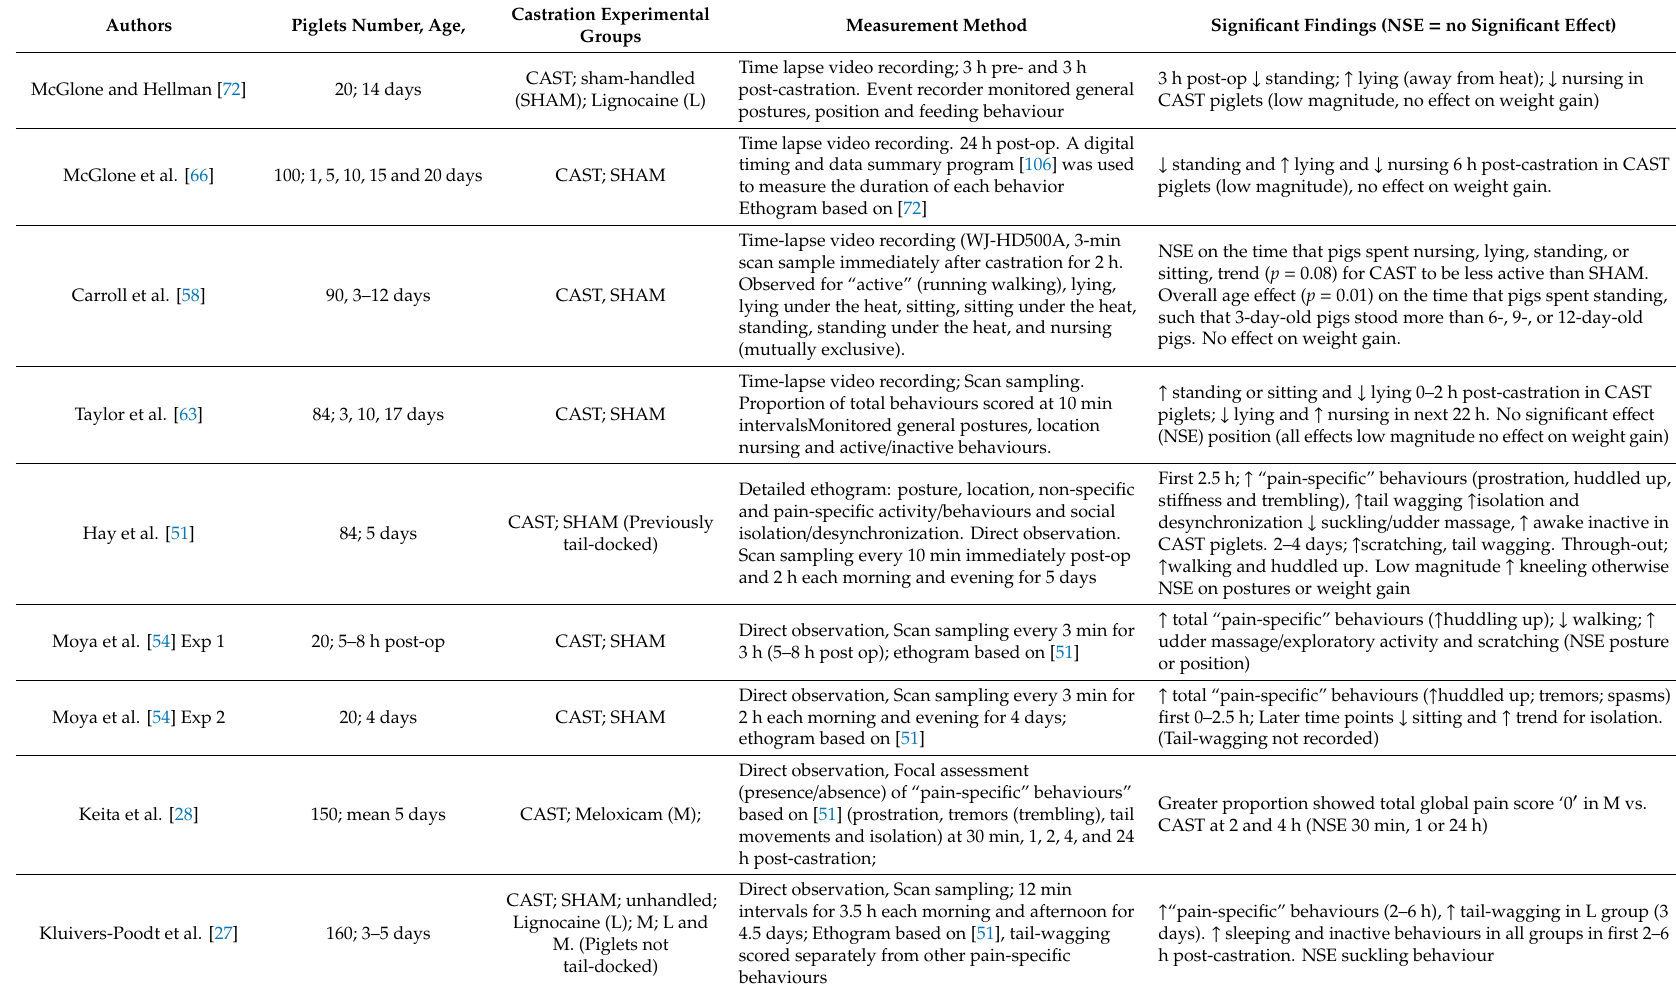
Table 4. Summary of behavioral studies in neonatal piglets following